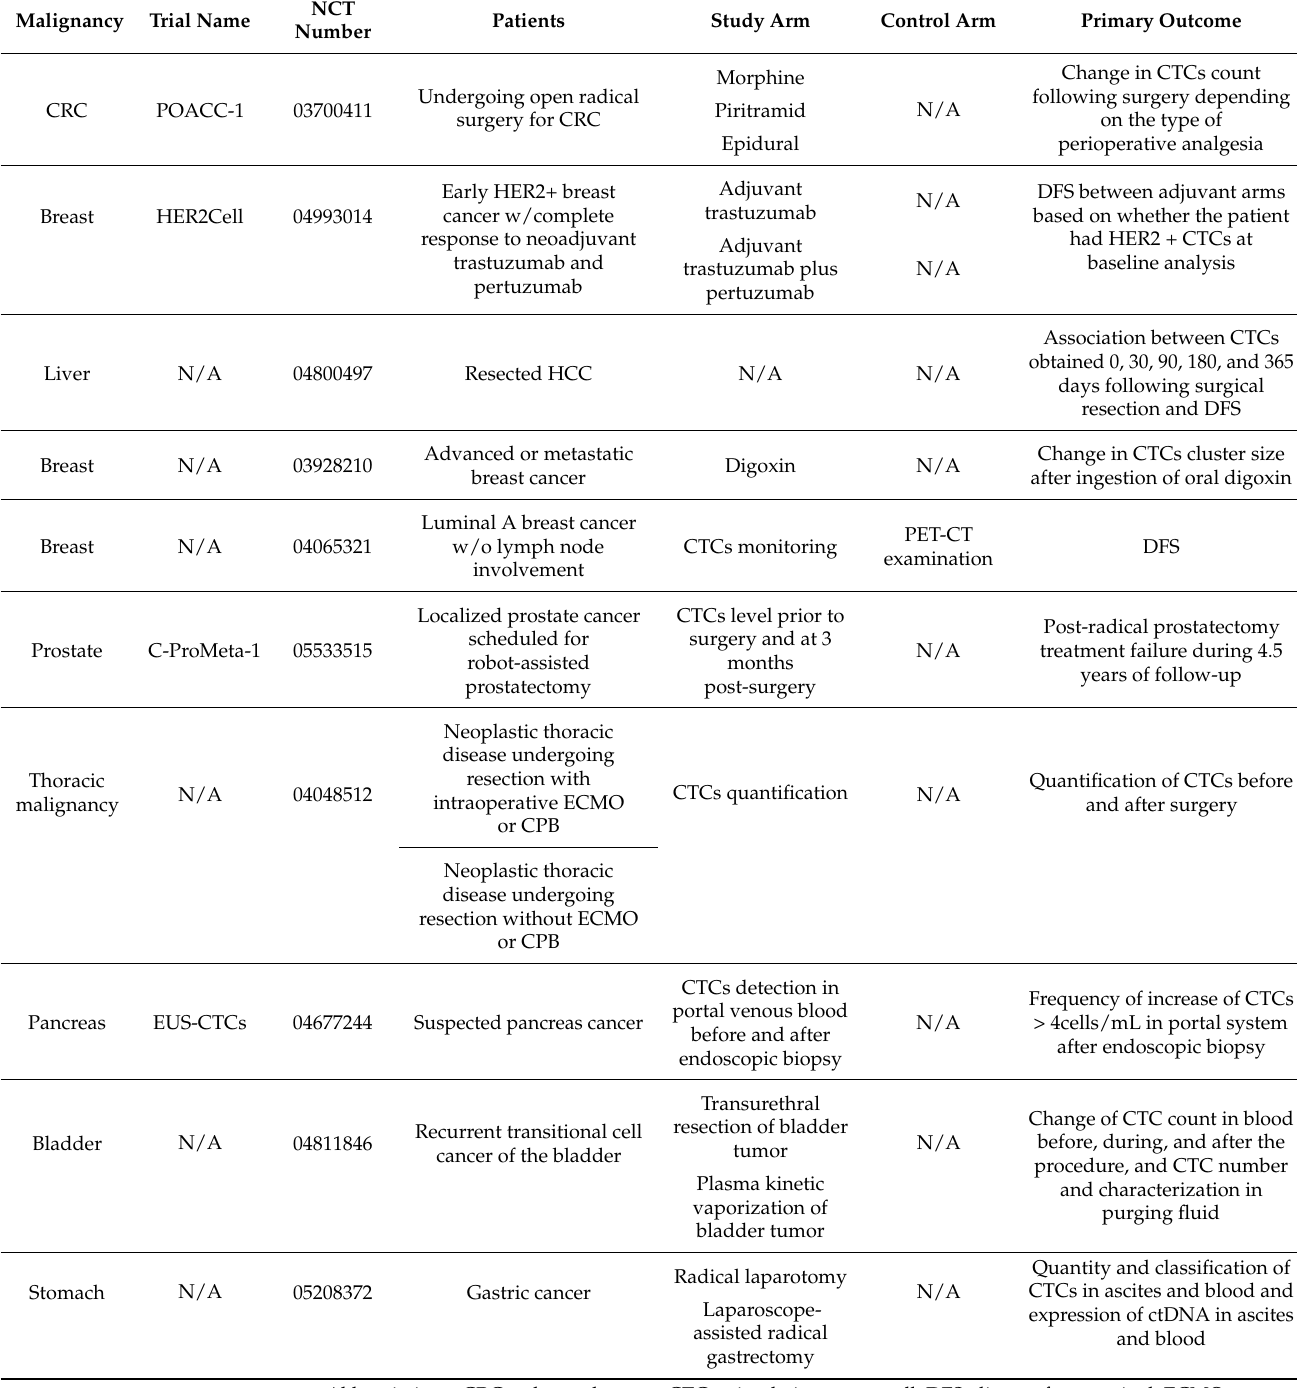
Table 4. Selected ongoing clinical trials in CTCs and solid